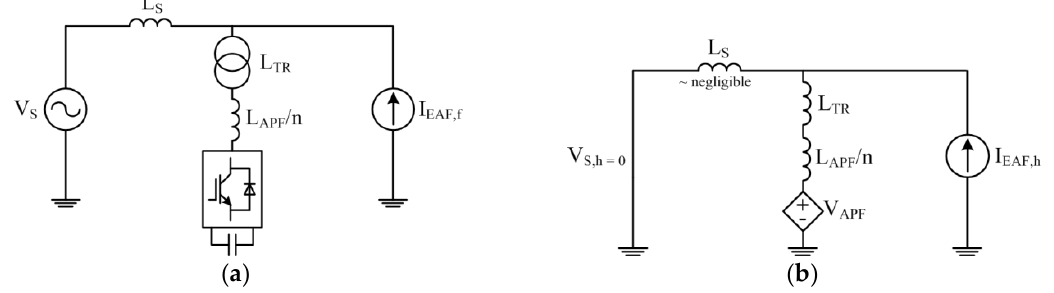
Figure 8. Single-phase equivalent circuit of the proposed system at ( a ) the fundamental frequency (50 Hz) and ( b ) any harmonic or interharmonic frequency.